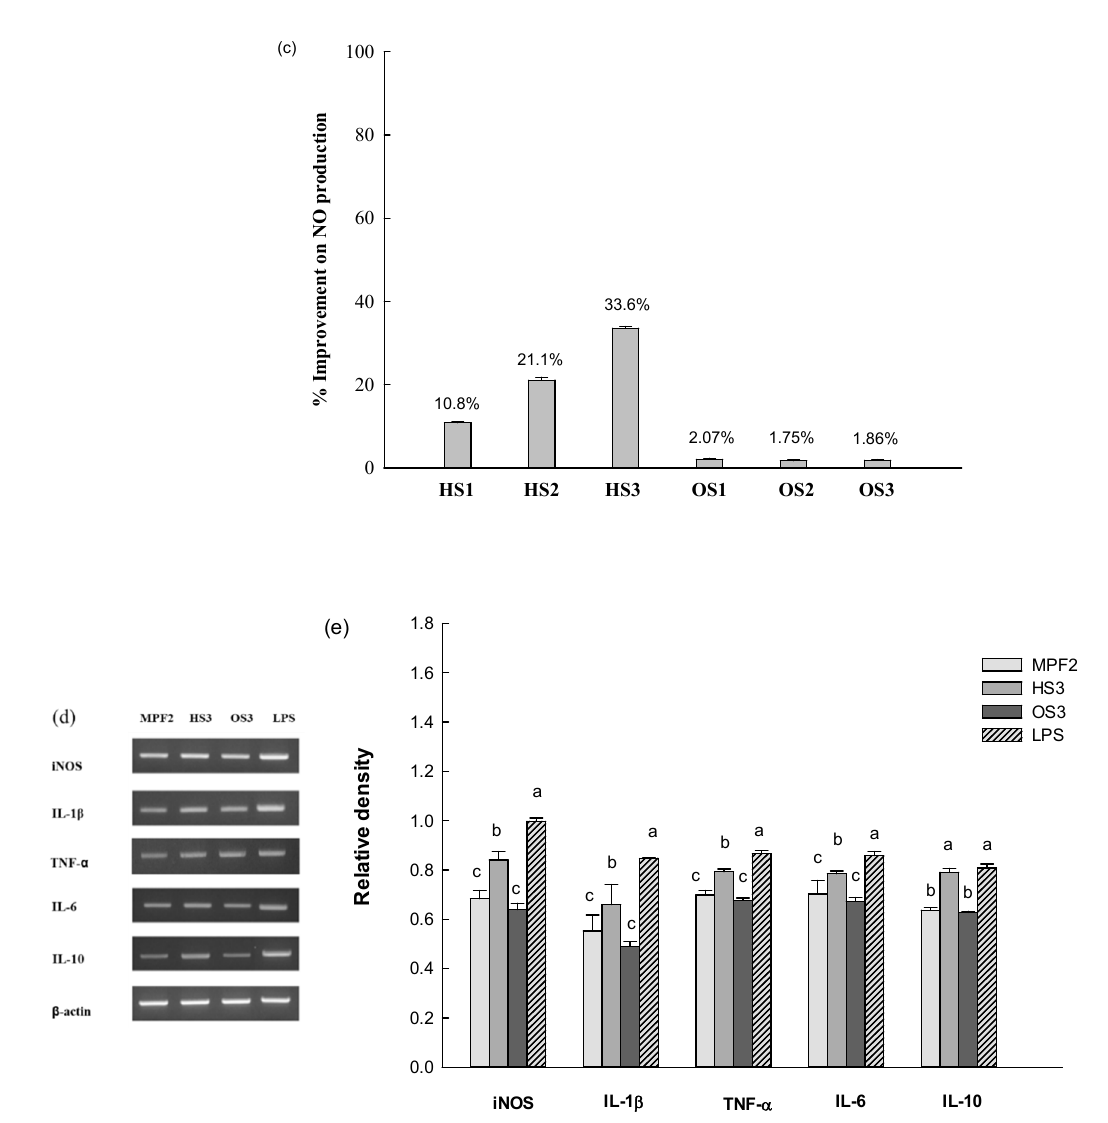
Figure 4. Effect of MPF2 and derivatives on RAW264.7 cells activities: ( a ) cell proliferation and ( b ) nitric oxide (NO) production in RAW264.7 cells, ( c ) percentage improvement on NO production, ( d ) mRNA expression in RAW264.7 cells, ( e ) and relative band intensity. Different letters indicate significant differences ( p < 0.05) between MPF2 and its derivatives at each cytokine.